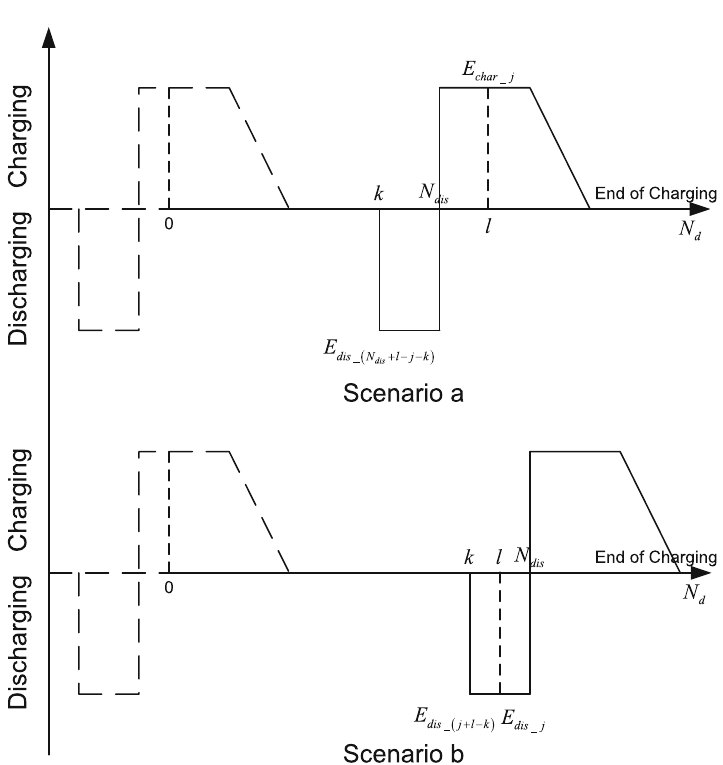
Fig. 2 Schematics of the two scenarios starting from discharging process of a single EV